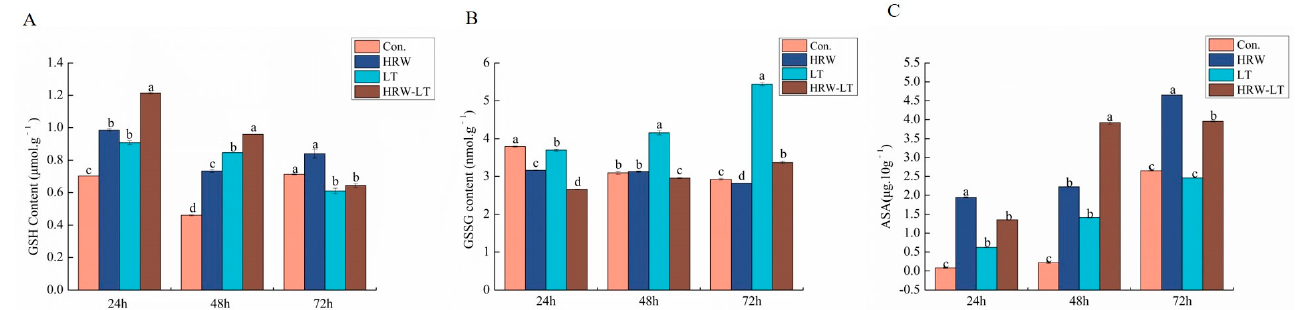
Figure 11. Effect of HRW on the nonenzymatic system of cucumber seedlings under chilling stress ( A ) GSH; ( B ) GSSG; ( C ) ASA. Data are the mean ± standard deviation of three biological replicates. The different letters indicate a significant difference ( p < 0.05).